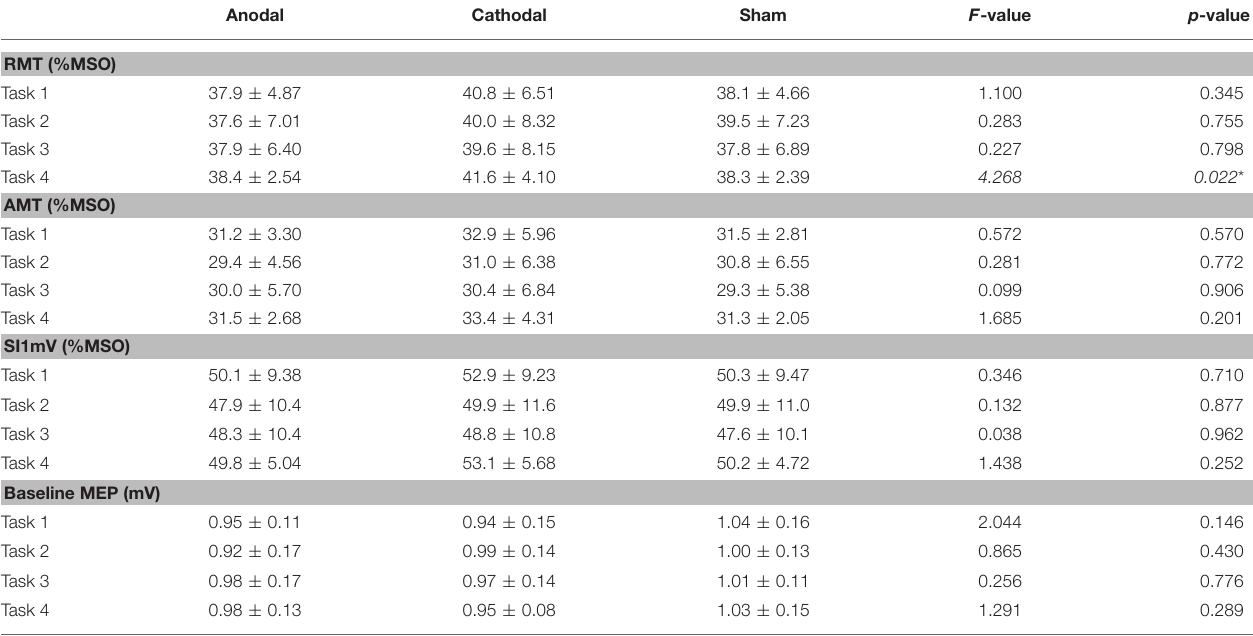
TABLE 1 | Baseline characteristics. Anodal Cathodal Sham F -value p -value